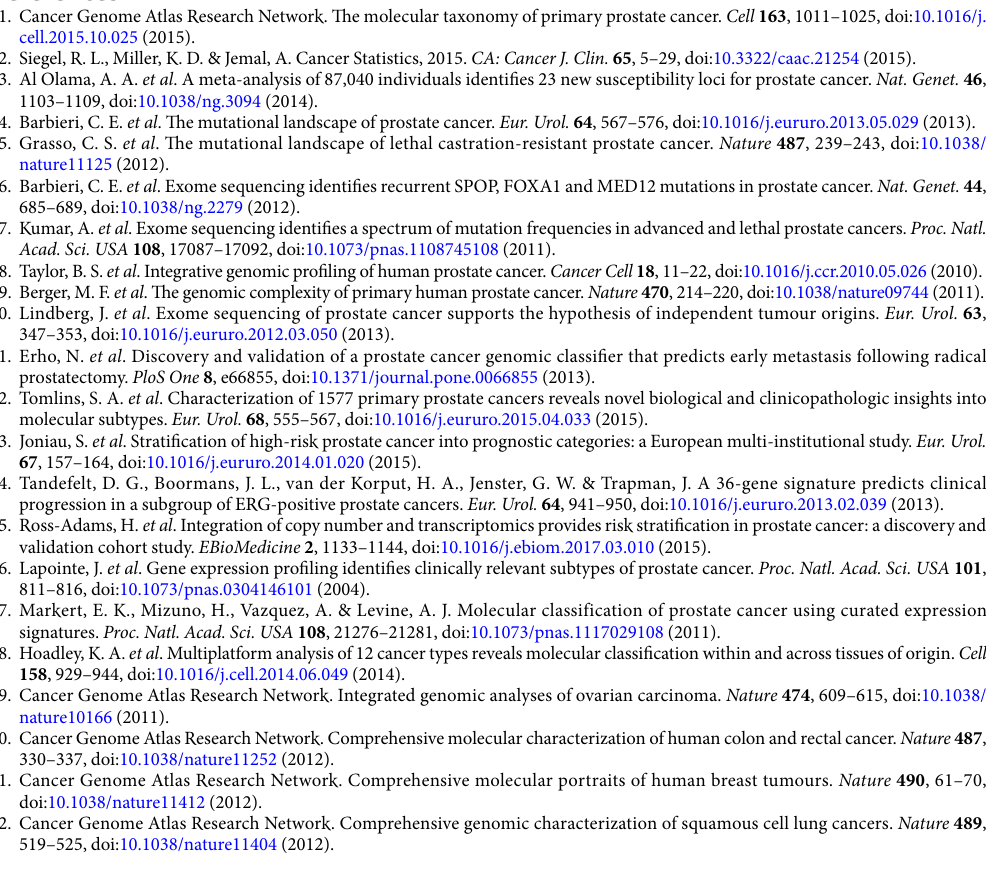
algorithm-specific parameters, including the Elastic Net mixing parameter: alpha, and the regularization parame- ter: lambda. Next, the Elastic Net algorithm was also used to select distinctive features for each molecular subtype. The features identified within each subtype were considered as the biomarkers of this